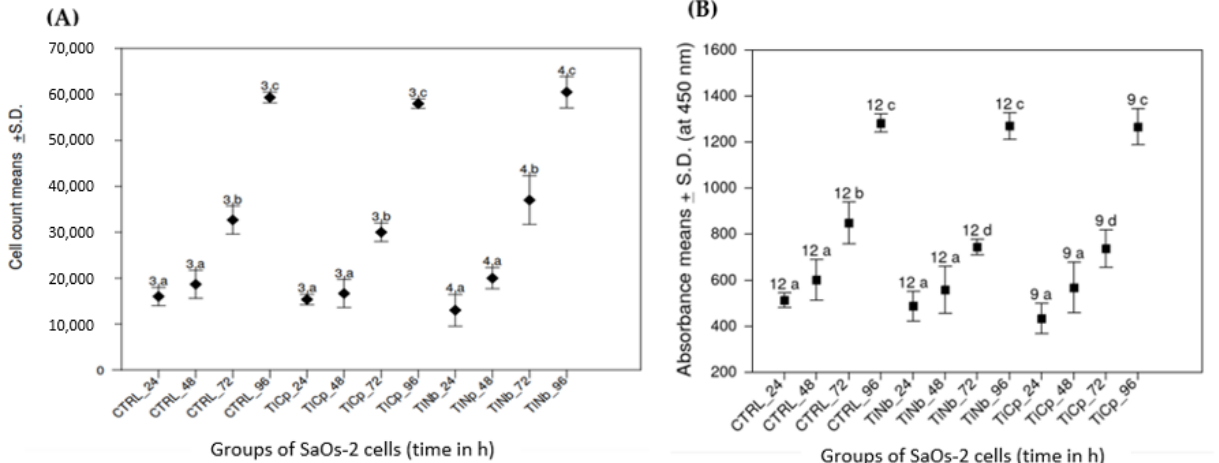
Figure 2. Grown ( A ) and metabolic activity ( B ) of SaOs-2 cells onto to S_TiCp and S_TiNb discs compared to CTRL polystyrene surface. Single-classification ANOVA. The number and the letter displayed onto the bars indicate, respectively, sampling replicates and statistical group. Groups not sharing the same letter are different on the 95% level (Tukey-Kramer method). Absorbance at 450 nm is expressed in mA; ‘CTRL’, ‘TiNb’ (S_TiNb) and ‘TiCp’ (S_TiCp) groups: growth on polystyrene, smooth TiNb and smooth TiCp alloys, respectively, for 24, 48, 72 and 96